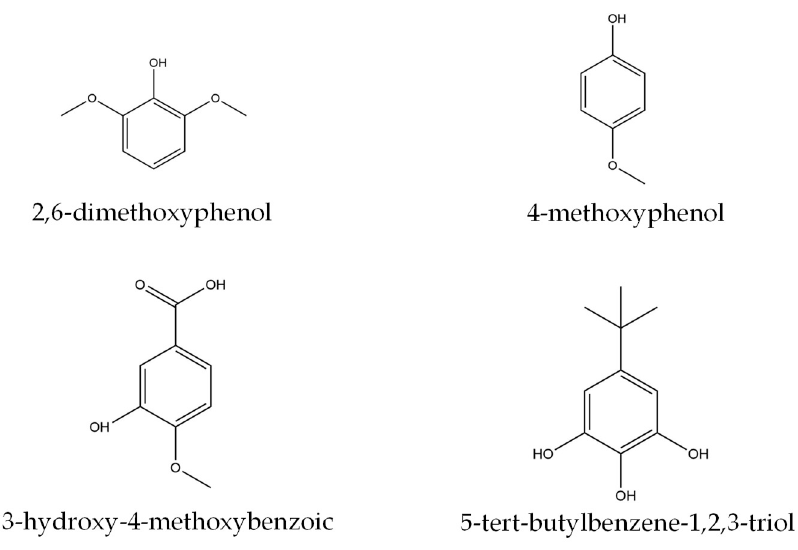
Figure 2. The chemical structure of several phenolic compounds in the BO.